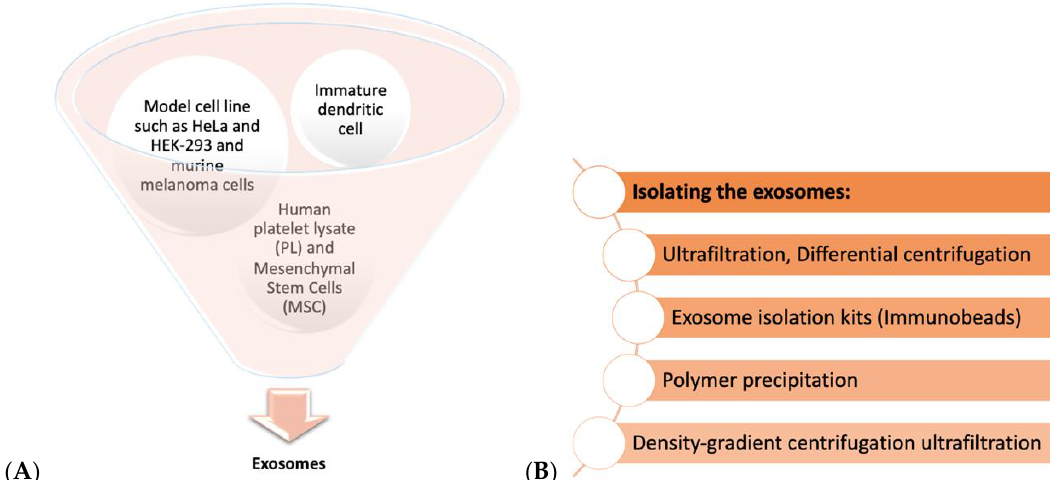
Figure 3. Summary of cell sources and methods used to isolate exosomes. ( A ) Sources of donor cells where exosomes have been isolated. ( B ) Methods of exosome isolation: ultrafiltration exosome isolation kits, polymer precipitation, differential centrifugation, and density-gradient centrifugation ultrafiltration